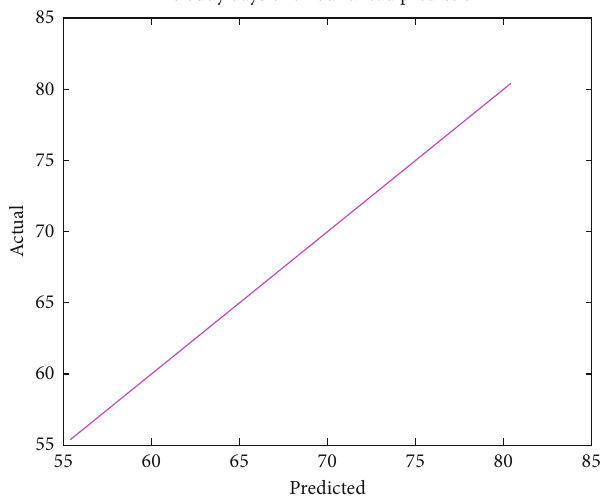
Figure 24: Relationship between actual vs. predicted solar irradiance for cloudy day one-hour-ahead